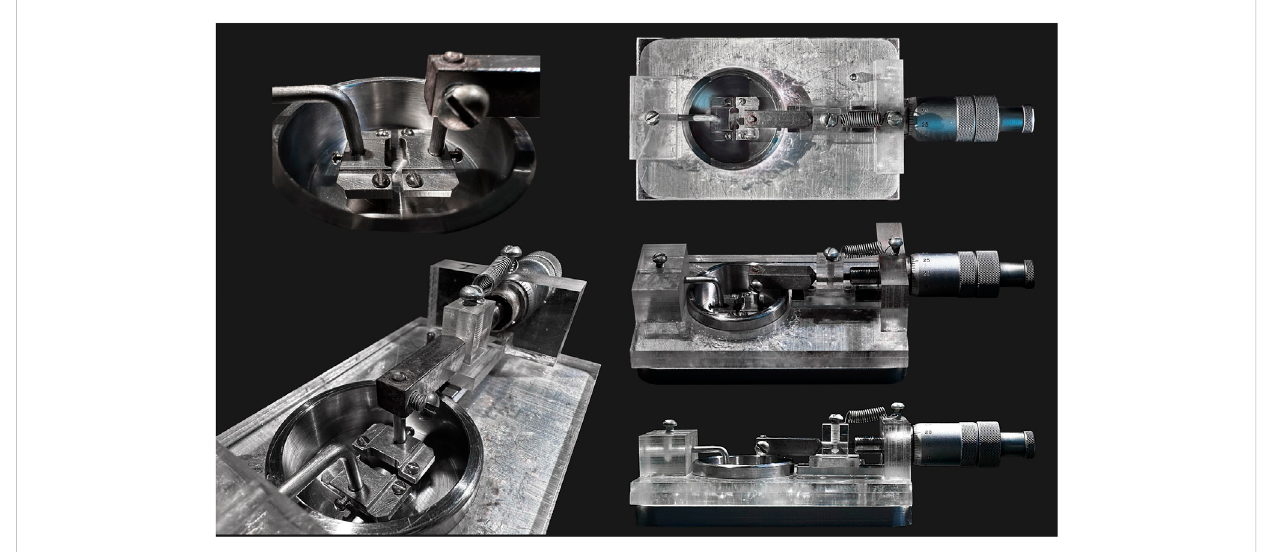
FIGURE 7 Custom-made wire myography analogue. This device is equipped with wider heads to increase arterial segment length up to 10 mm. It has a micrometer that allows to change the distance between the heads but has no force